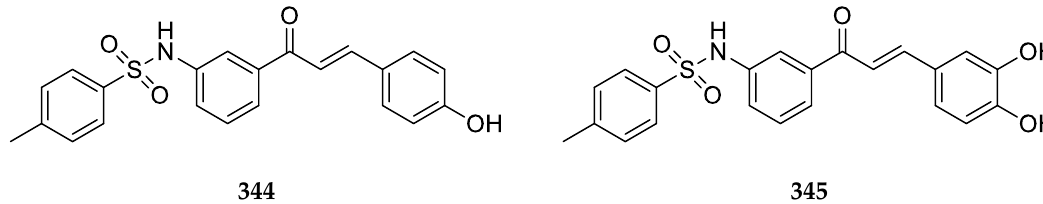
Figure 85. Chemical structure of sulfonamide-3-aminochalcone derivatives with substitution on ring